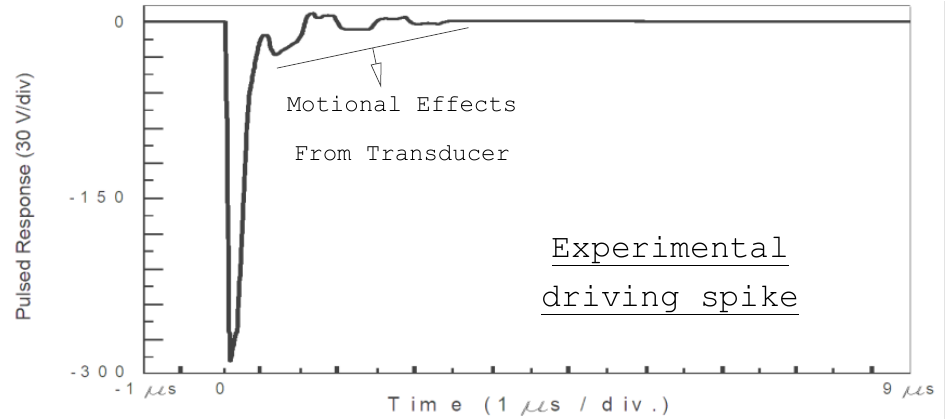
Figure 8. Measured HV spike waveform when driving a broadband piezoelectric transducer in the MHz range (Q269), showing mechanical influences from transducer vibrations during the first 4 µs.